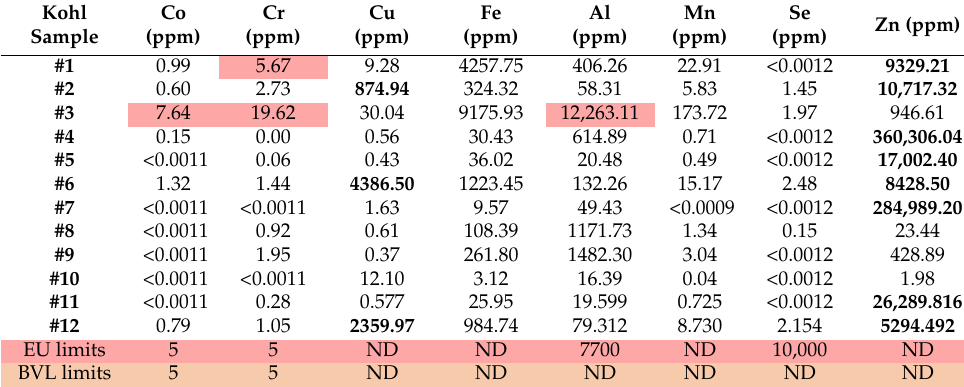
Table 5. Levels of other metals ( ppm or µ g/g) in kohl samples compared to the limitations estab- lished by governmental institutions. Red boxes indicate values above the German Federal Office of Consumer Protection and Food Safety ( BVL ) [45,46] and the European Union legal limits [40]. ND : not described. Kohl Co Cr Cu Fe Al Mn Sample (ppm) (ppm) (ppm) (ppm) (ppm)